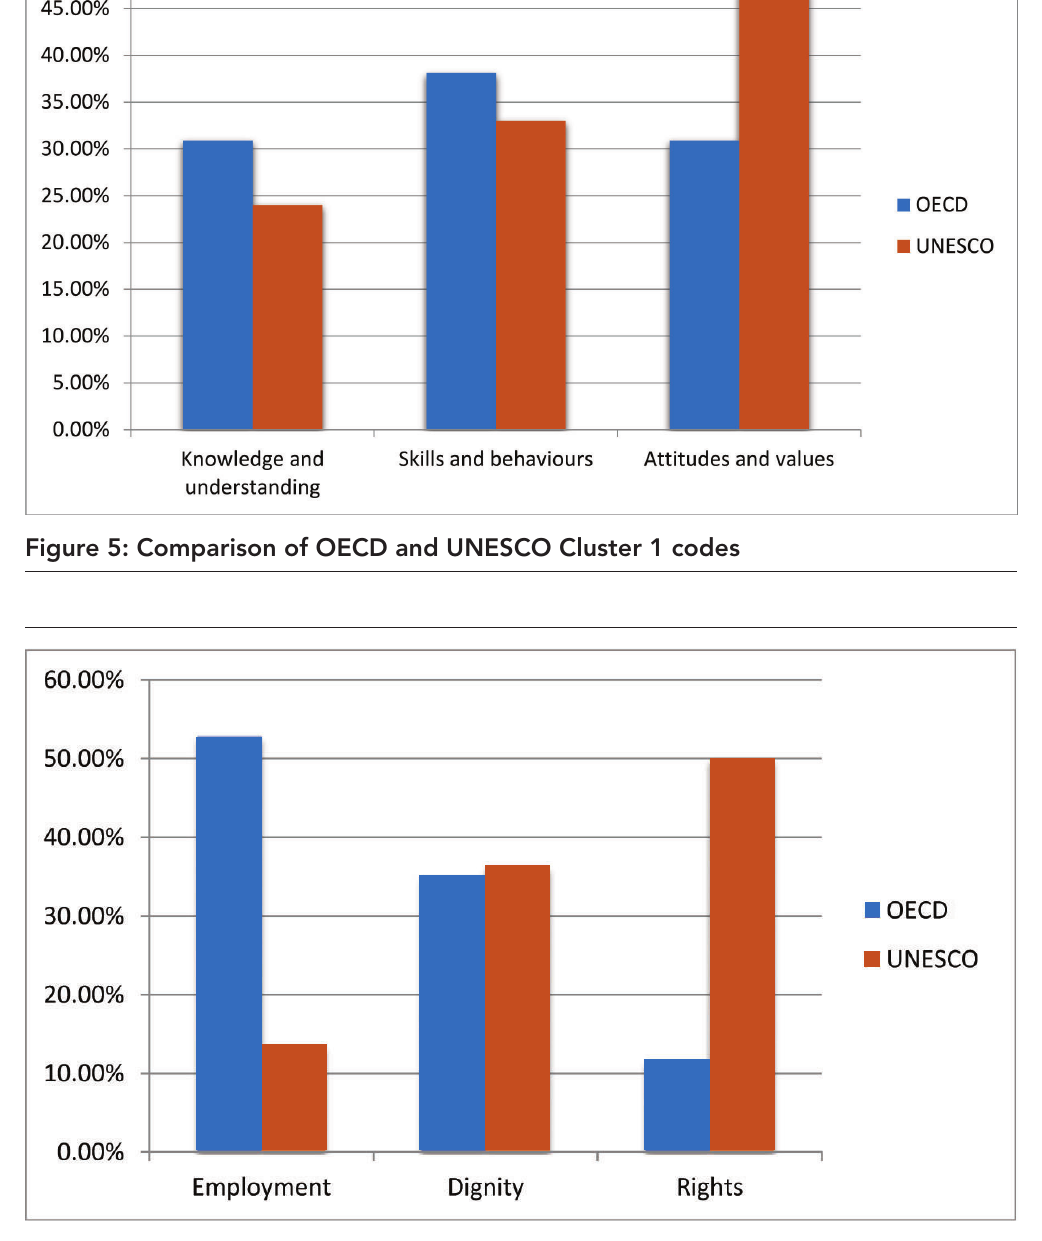
Figure 6: Comparison of OECD and UNESCO Cluster 2